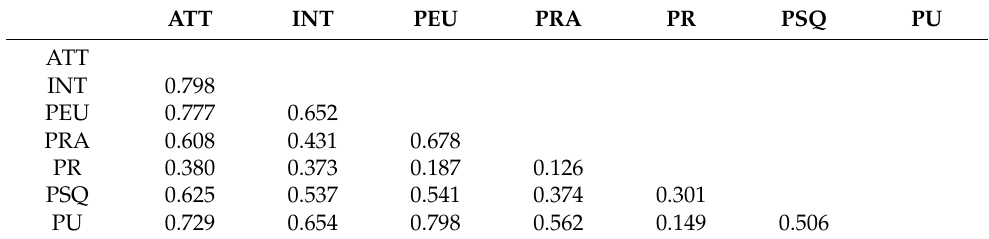
Table 7. Heterotrait–Monotrait (HTMT) values. ATT INT PEU PRA PR PSQ